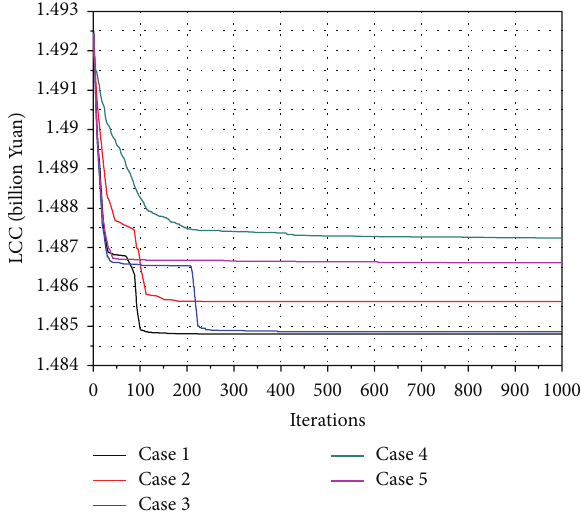
Figure 8: Algorithm calculation in comparison with different parameters (6 heat sources).